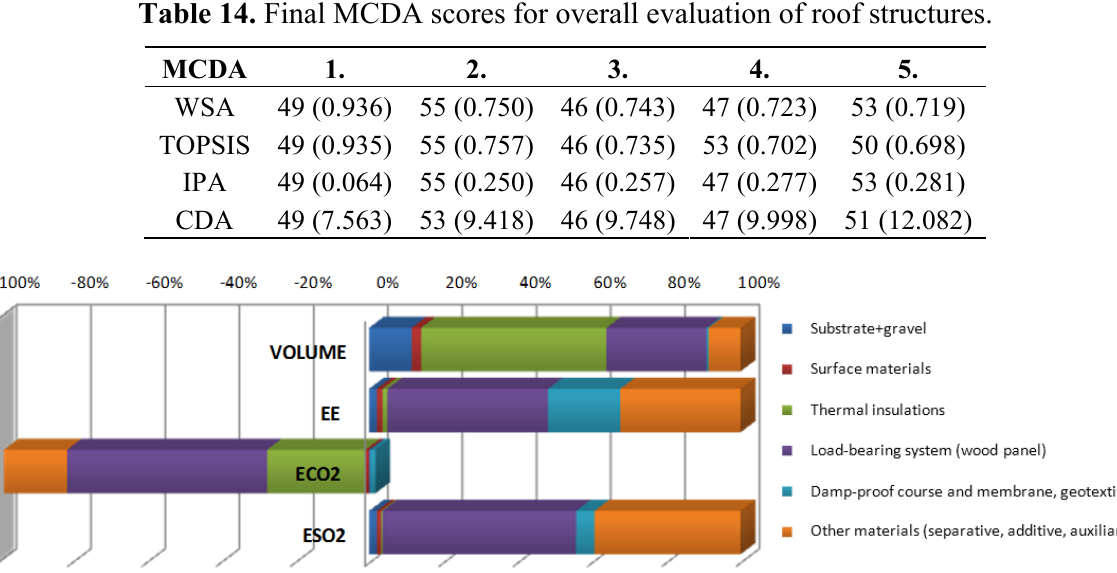
Figure 14. Roof structure: Materials share by percentage and impact on environmental